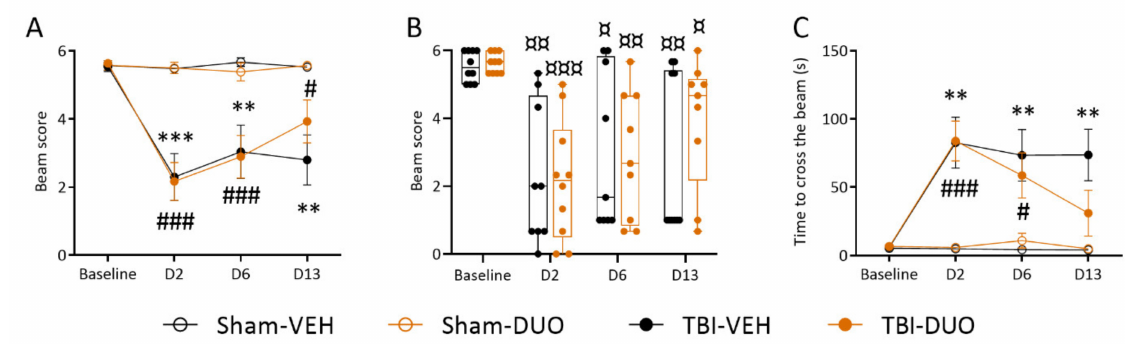
Figure 6. Beam walking in rats treated with vehicle or SFN+NAC duotherapy. ( A ) Both TBI-VEH and TBI-DUO groups were impaired in the beam walking test until day (D) 13 post-TBI. ( B ) A whisker-plot showing the distribution of scores in each animal throughout the 2-week follow-up. Interestingly, rats in the TBI-VEH group tended to cluster into the poorly-performing group (6 of 10 rats [60%] scoring 0-1) and rats in the TBI-DUO group into well-performing group (6 of 9 rats [67%] scoring 4-6), particularly at the end of the testing period. ( C ) The TBI-VEH group was impaired in beam crossing throughout the 2-week follow-up. The TBI-DUO group improved after D2, and did not differ from the Sham-DUO group on D13. Abbreviations: D, day; DUO, duotherapy treated with N-acetylcysteine and sulforaphane; NAC, N-acetylcysteine; SFN, sulforaphane; TBI, traumatic brain injury, VEH, vehicle; wk, week. Statistical significances: ** p < 0.01, *** p < 0.001 (Sham-VEH vs. TBI-VEH, independent sample t -test); # p < 0.05, ### p < 0.001 (Sham-DUO vs. TBI-DUO, independent sample t -test); ¤ p < 0.05, ¤¤ p < 0.01, ¤¤¤ p < 0.001 as compared to corresponding baseline (paired sample t-test). Data are presented as mean ± SEM or as whisker-plots with mean and